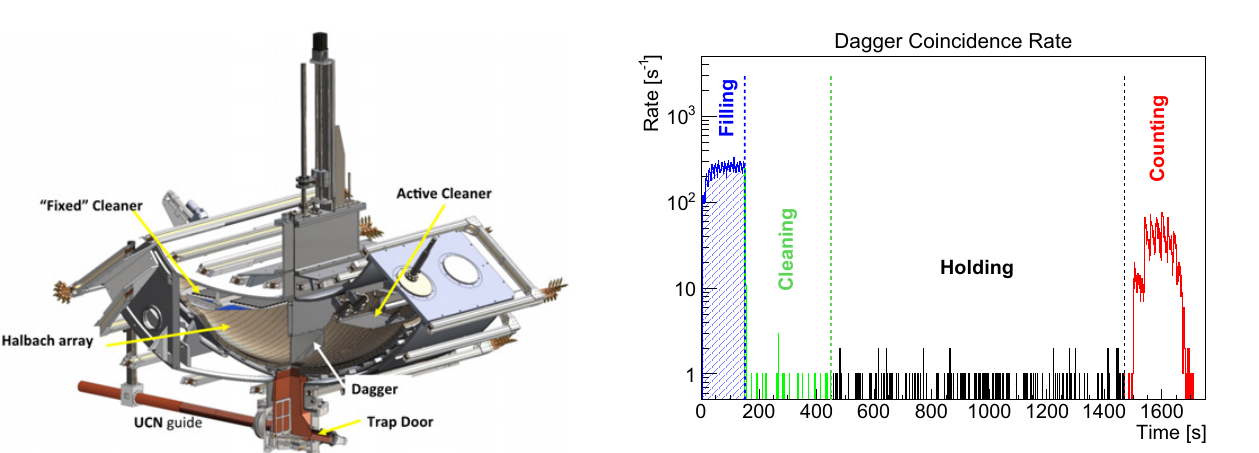
Figure 1. A cut-away view of the UCN τ trap.